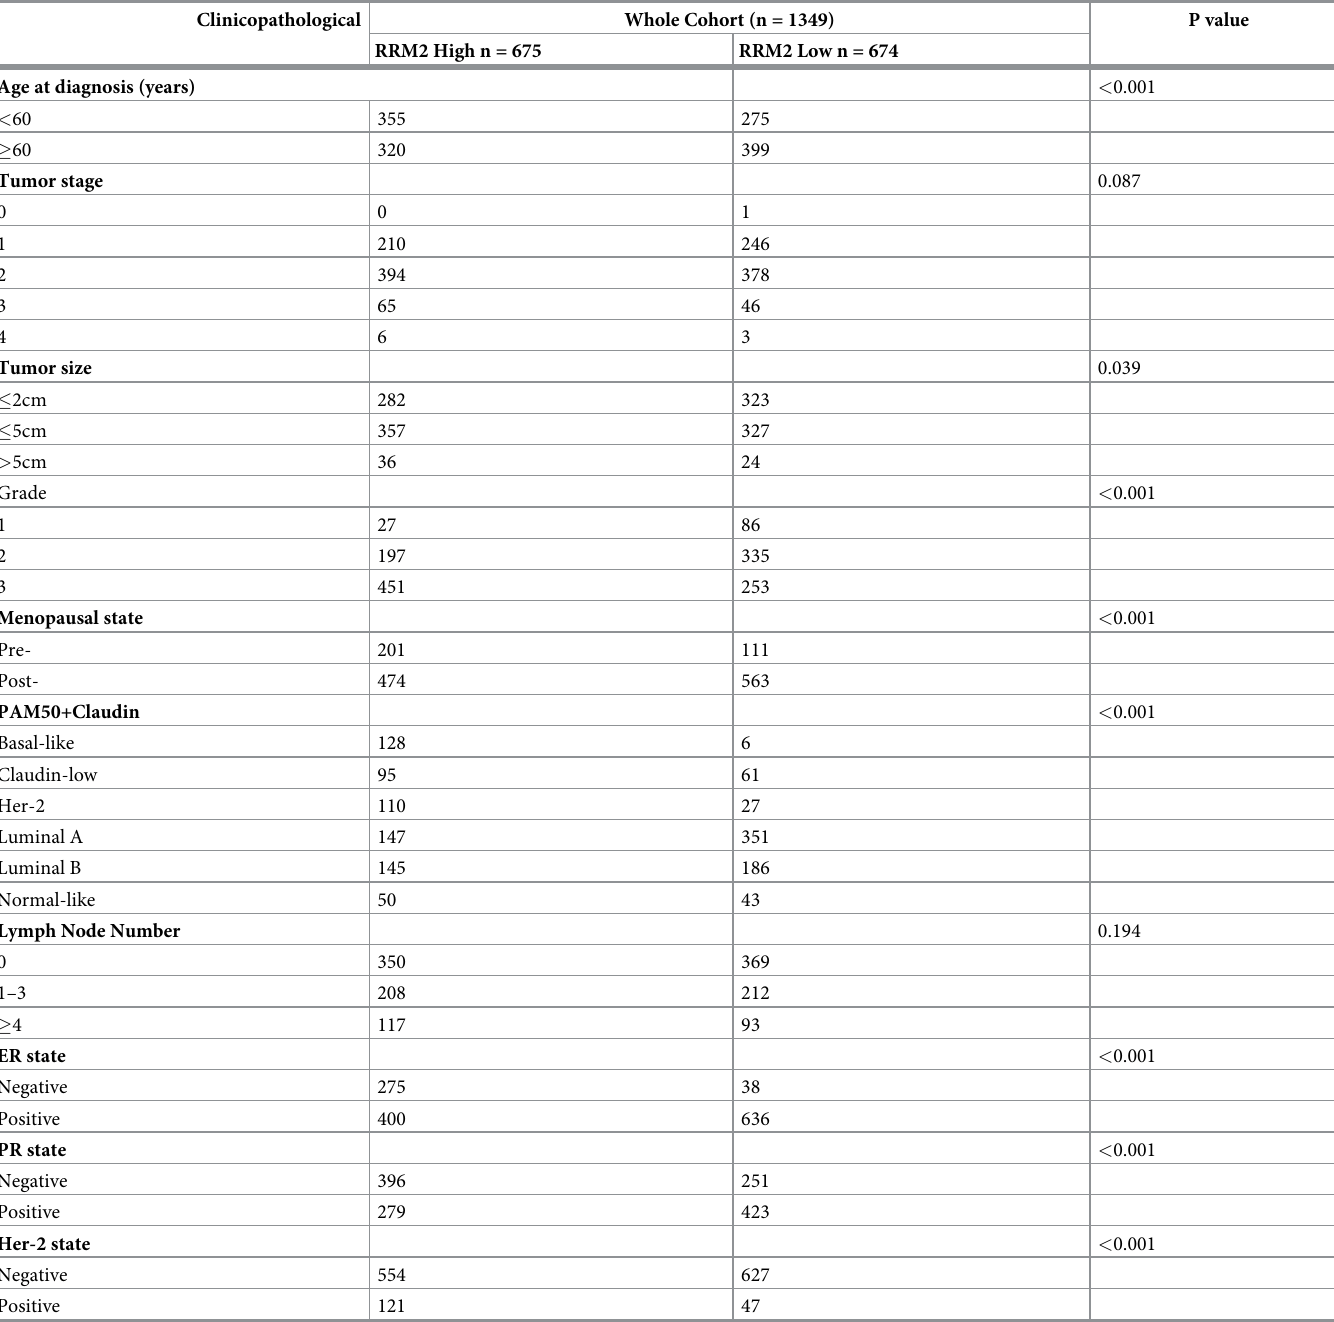
Table 1. The correlation between the expression level of RRM2 and the clinicopathological characteristics of breast cancer patients in the METABRIC database.